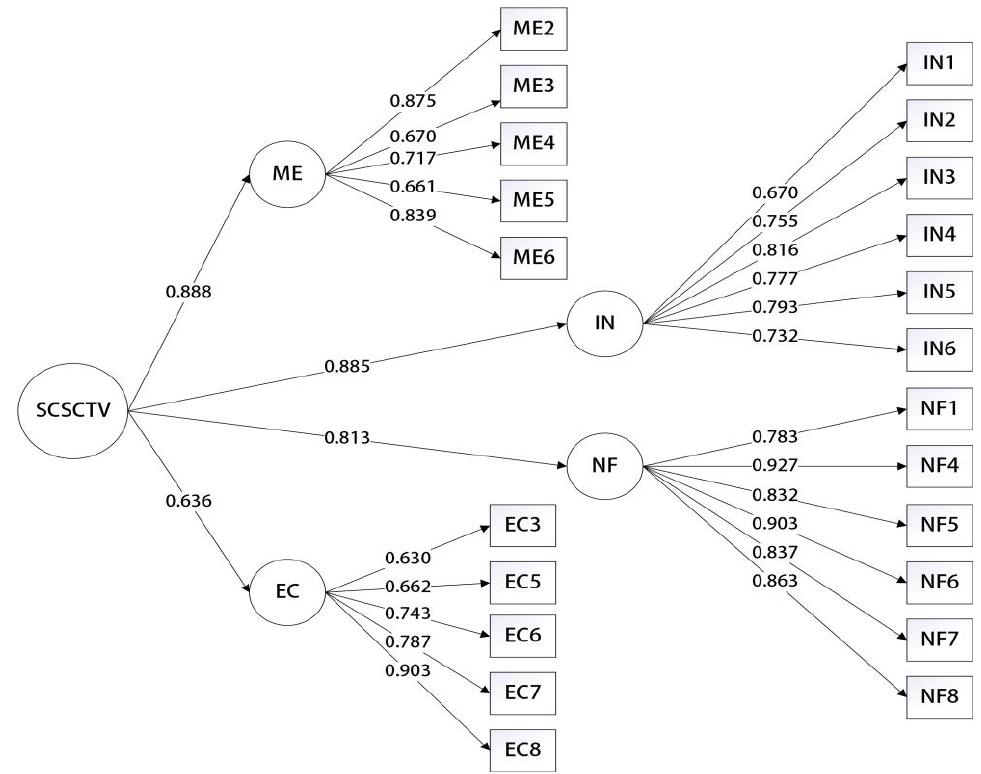
Figure 6. Factor loadings of the four-factor SCSCTV with 22 items.